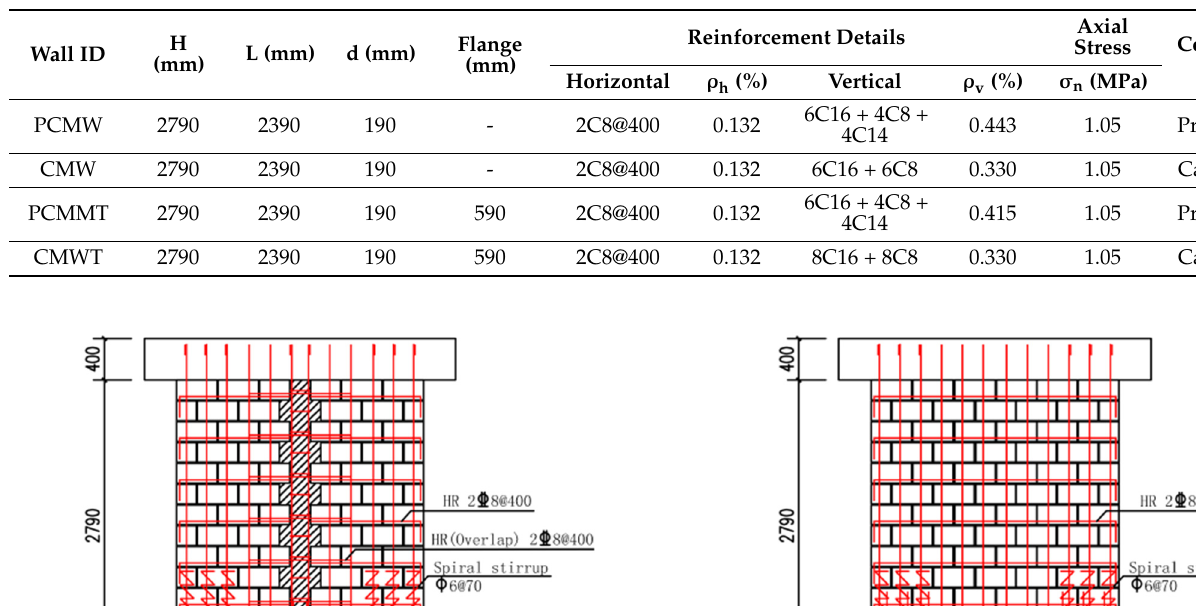
Table 1. Dimensions and reinforcement details of the test walls.